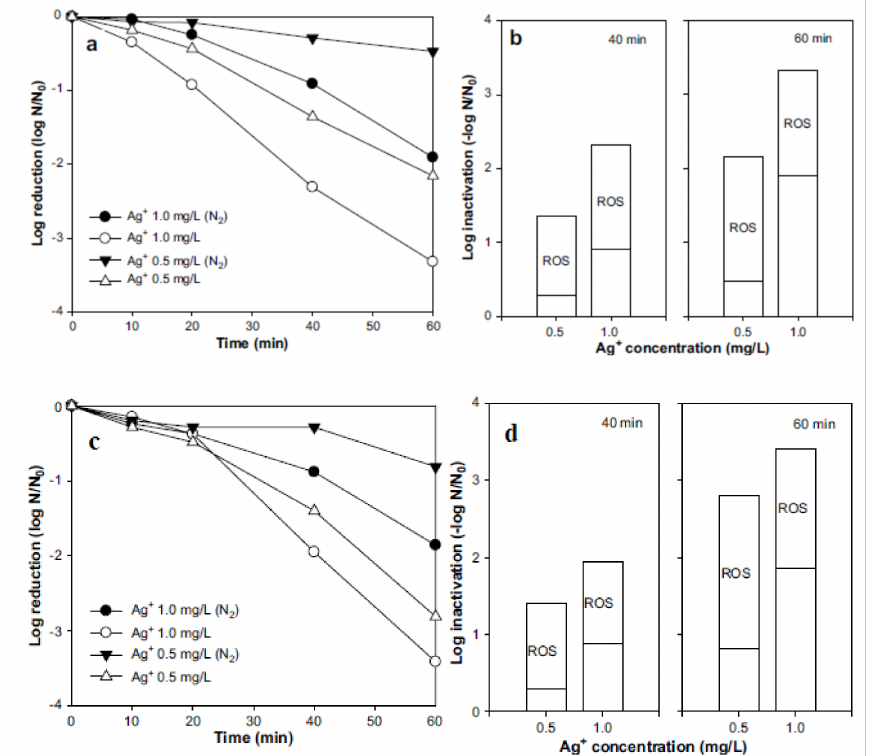
Figure 12. ( a ) The effect of Ag ions on the inactivation of E. coli ATCC8739 in the absence or presence of oxygen. ( c ) The effect of silver ions on the inactivation of S. aureus ATCC6538. ( b , d ) The proportion of ROS-mediated inactivation by silver ions at 40 and 60 min ( N 0 = 10 6 CFU/mL, pH 7.1) (adapted with permission from reference